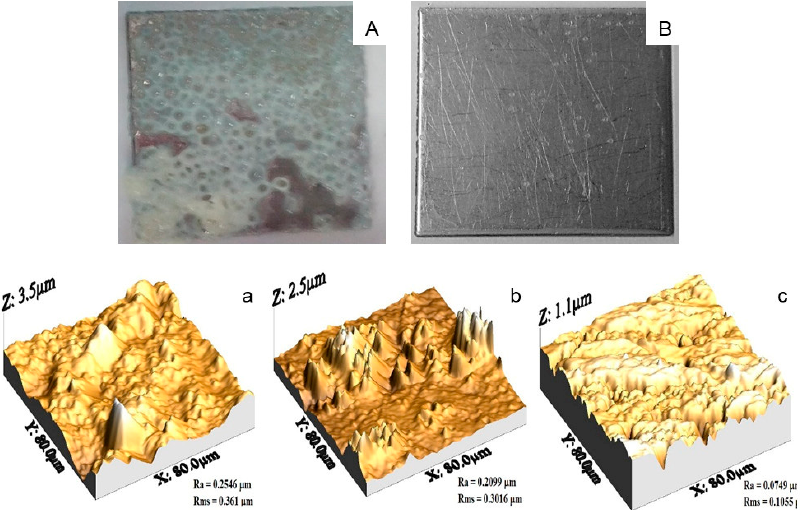
Figure 2. Appearance of SSP with deposits type ( A ) (panel A), and type ( B ) (panel B). AFM micro- graphs of SSP plates: ( a ) type A deposits; ( b ) type B deposits; ( c ) SSP without deposits.